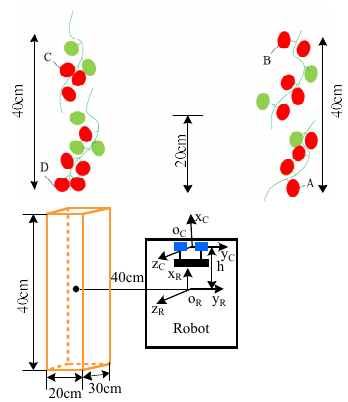
Figure 6. Confirmation of the operational area for picking tomatoes and the next stop point.